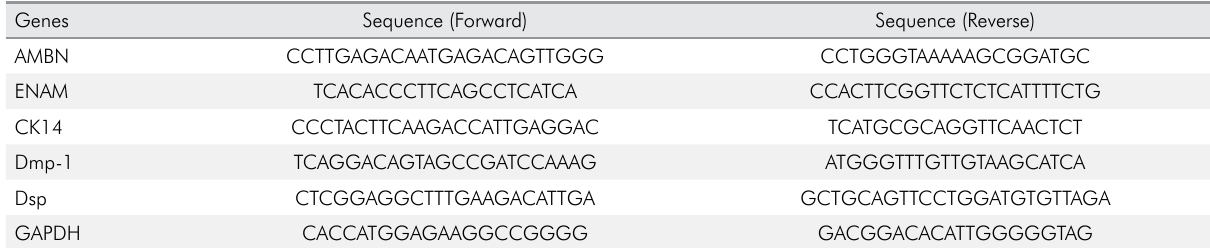
Table. Primers for quantitative real-time